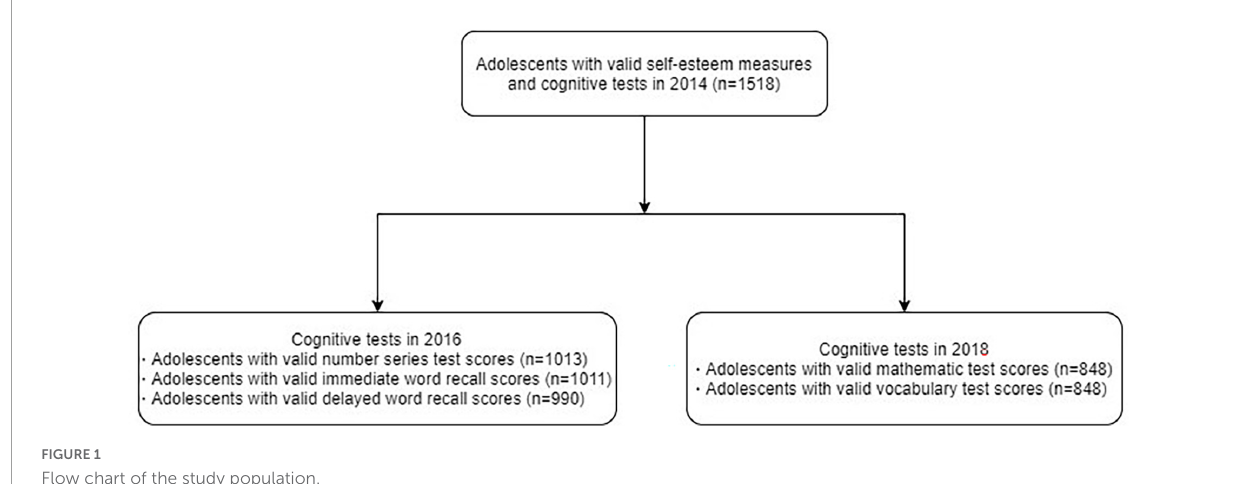
FIGURE1 Flow chart of the study